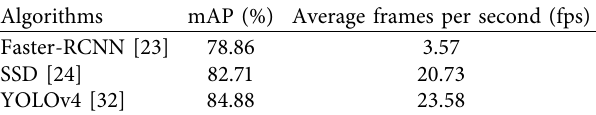
Table 2: Effectiveness of 3 target detection